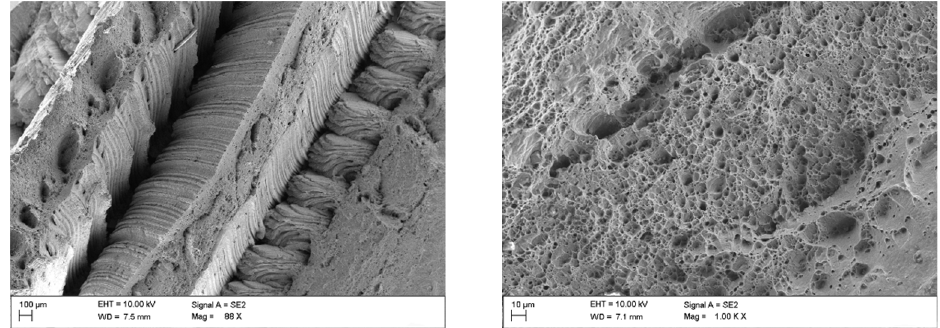
Figure 14. SEM morphology of fracture surface: process parameter = 1400 RPM, 65 mm/min, and probe offset = 1.0 mm.